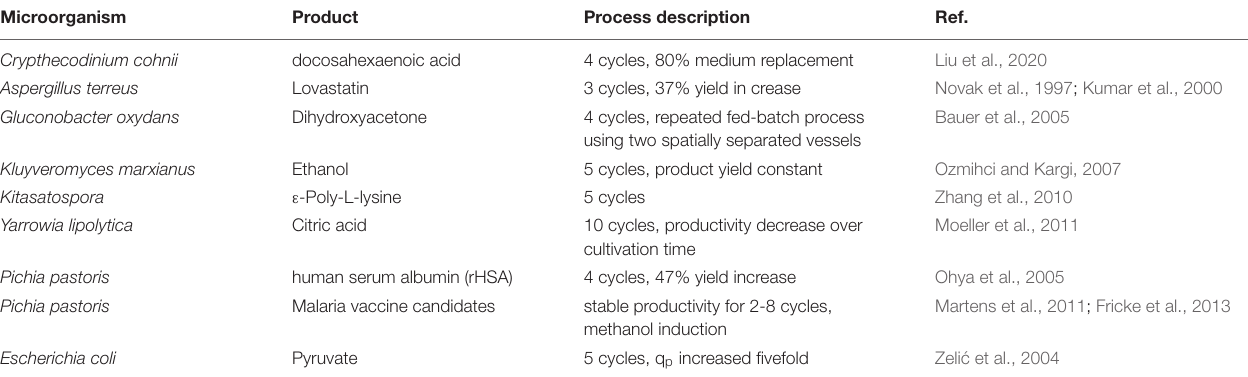
TABLE 1 | Summary of studies about repetitive fed-batch